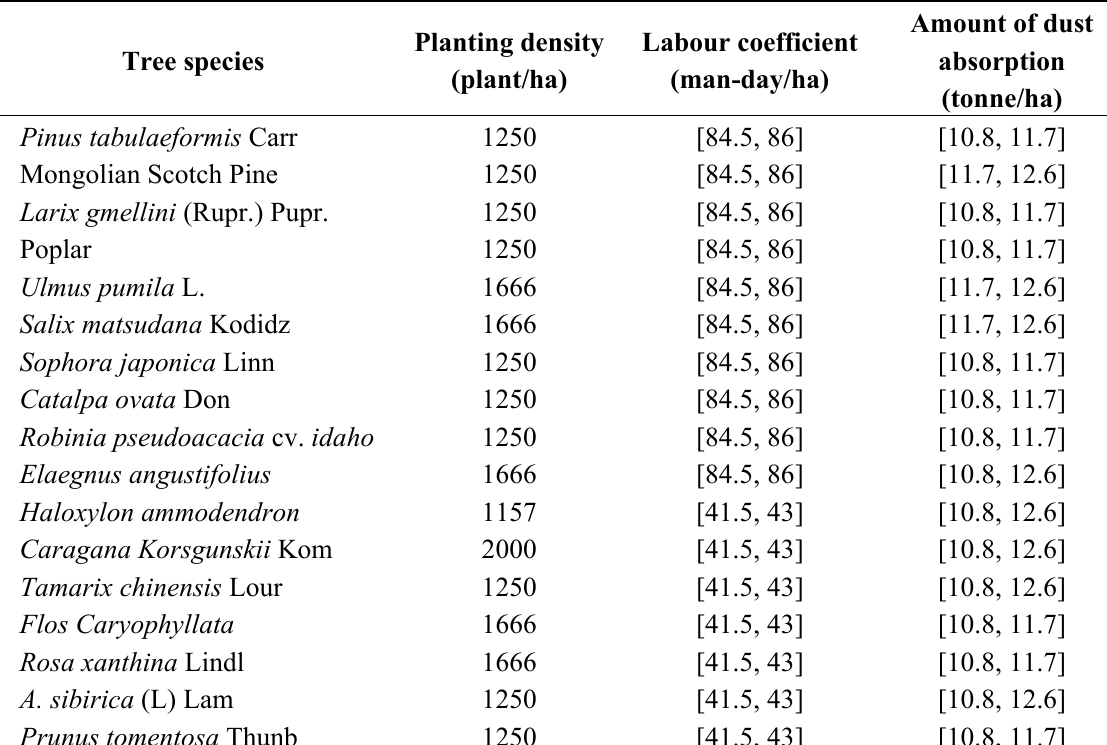
Table 3. Technical parameters of the CDM forestry project.